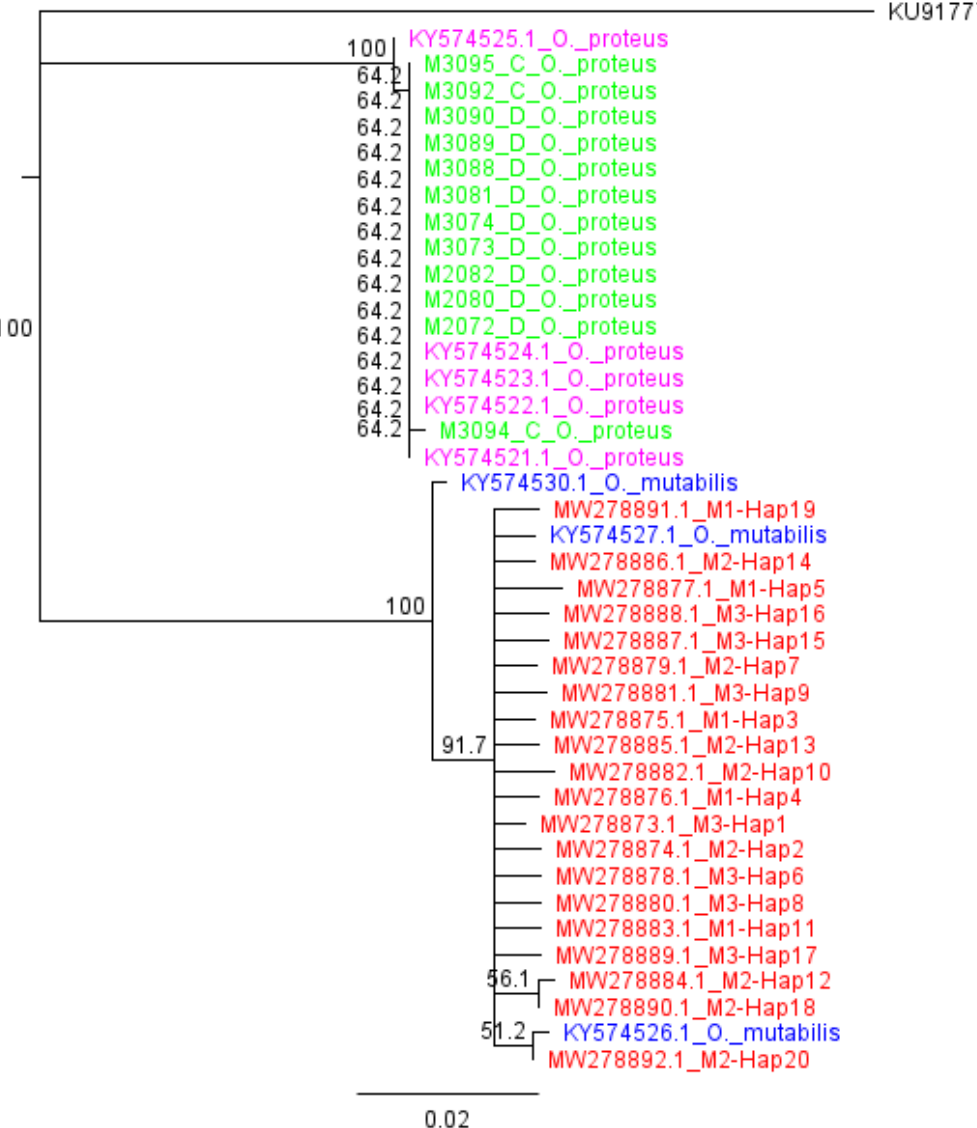
Figure 4. Neighbour Joining phylogenetic tree of the 20 O. mutabilis haplotypes (red) found in the study, and reference sequences downloaded from NCBI as follows: O. mutabilis (blue), O. proteus (pink), O. proteus (green, morphologically similar samples to O. mutabilis separated after DNA-barcoding) and the outgroup Longitarsus tabidus . Table 7. ( a1 ): Non-hierarchical AMOVA for all the sixteen populations of O. mutabilis , and ( a2 ) hi- erarchical AMOVA for all the sixteen districts grouped into five agro-ecological zones based on SSR data; ( b1 ) non-hierarchical AMOVA for all sixteen populations of O. mutabilis, and ( b2 ) hierarchical AMOVA for all the sixteen populations grouped into their relative agro-ecological zones based on mt COI data.